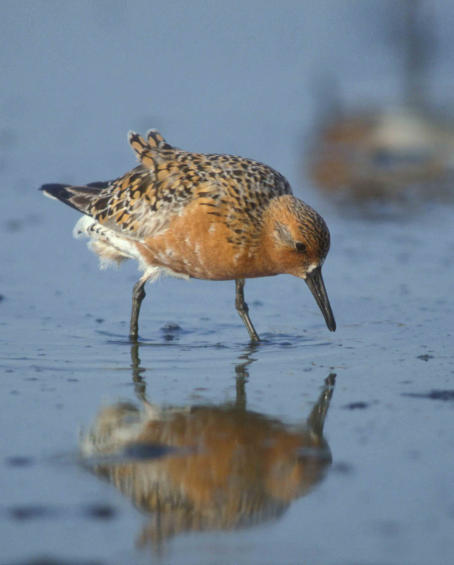
Commercial shellfish dredging in the Dutch Wadden Sea led to declines in both the quality and amount of the red knot's food resources, causing the population to crash. (Photo: Jan van de Kam)